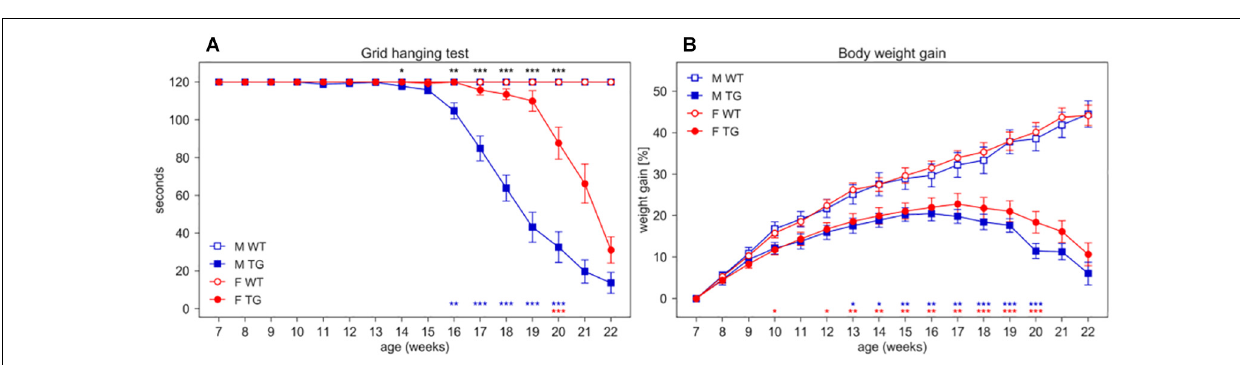
FIGURE 6 | Grid hanging test and body weight gain. (A) Latency to fall per mouse (average time ± SEM) of mice hanging from an inverted grid. (B) Average percentage of body weight gain ± SEM (per mouse) calculated from initial weight at age 7 weeks. Measures were taken weekly (weeks 7–22) in male (M, blue squares) and female (F, red circles) WT (open symbols) and SOD1G93A (TG, filled symbols) mice. N of mice per group: M WT = 17; M TG = 18; F WT = 22; F TG = 20. In each sex group (males = blue stars, females = red stars) * p < 0.05, ** p < 0.01, *** p < 0.001 WT vs. TG, D/AP post-hoc procedure. Since we found